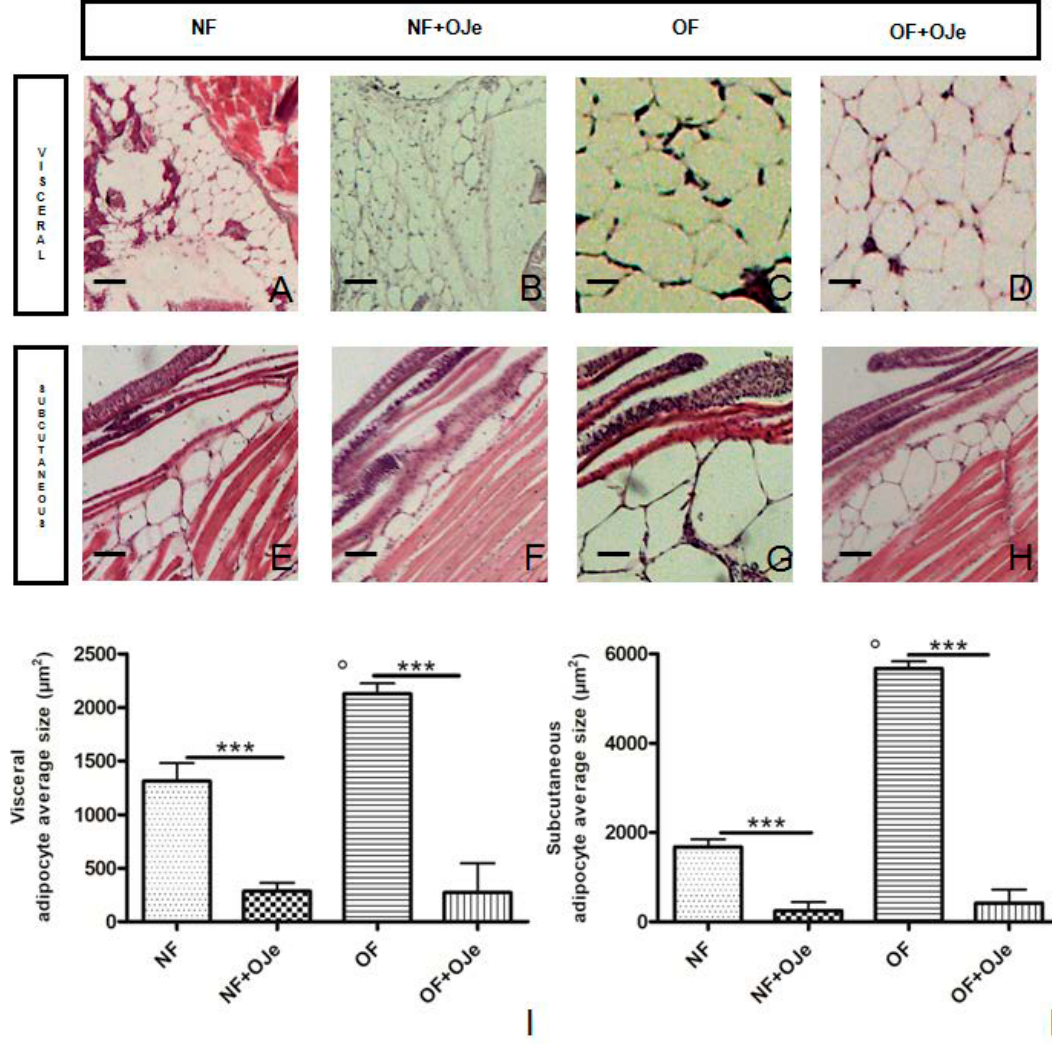
Figure 3. Effect of OJe on visceral and subcutaneous adipocyte size. Histological features of abdominal adipose tissue in sagittal sections (hematoxylin and eosin staining) showing visceral ( A – D , I ) and subcutaneous ( E – H , L ) adipocyte size in the four experimental groups. OJe treatment significantly reduced both visceral ( A – D , I ) and subcutaneous ( E – H , L ) average adipocyte size in both NF and OF fish. Photos ( A – H ) are representative of that (three per section) taken in 10 fish per group. Bar graphs show the results of the morphometric analysis of fat performed in both visceral ( I ) and subcutaneous ( L ) adipocyte average size in the four experimental groups (NF, NF + OJe, OF, and OF + OJe). Scale bars correspond to 20 µm. Results from the morphometric analysis in graphs ( I ) and ( L ) are expressed in µm 2 of adipocyte size and expressed as mean ± SD of 15 fish per each group. *** p < 0.001 vs respective counterparts; ° p < 0.001 vs NF.